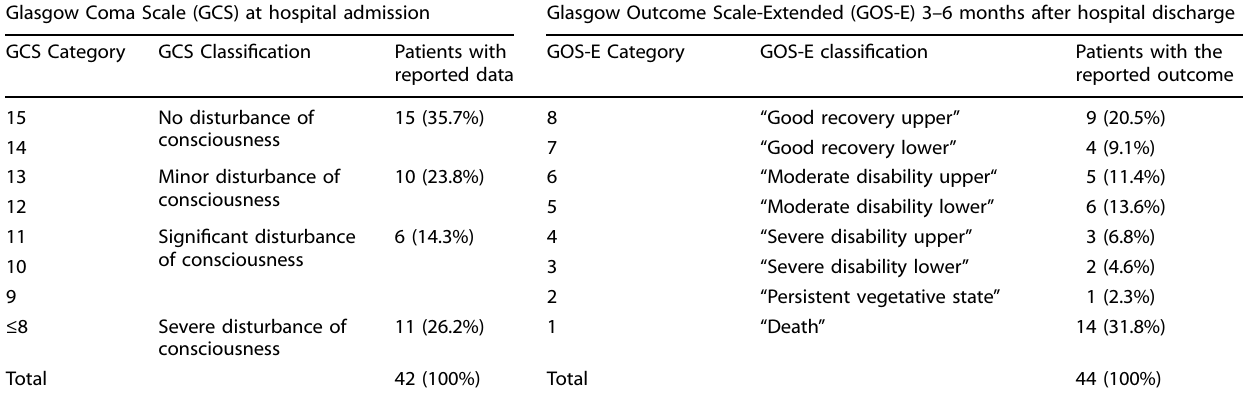
Table 1. GCS and GOS-E of patients with